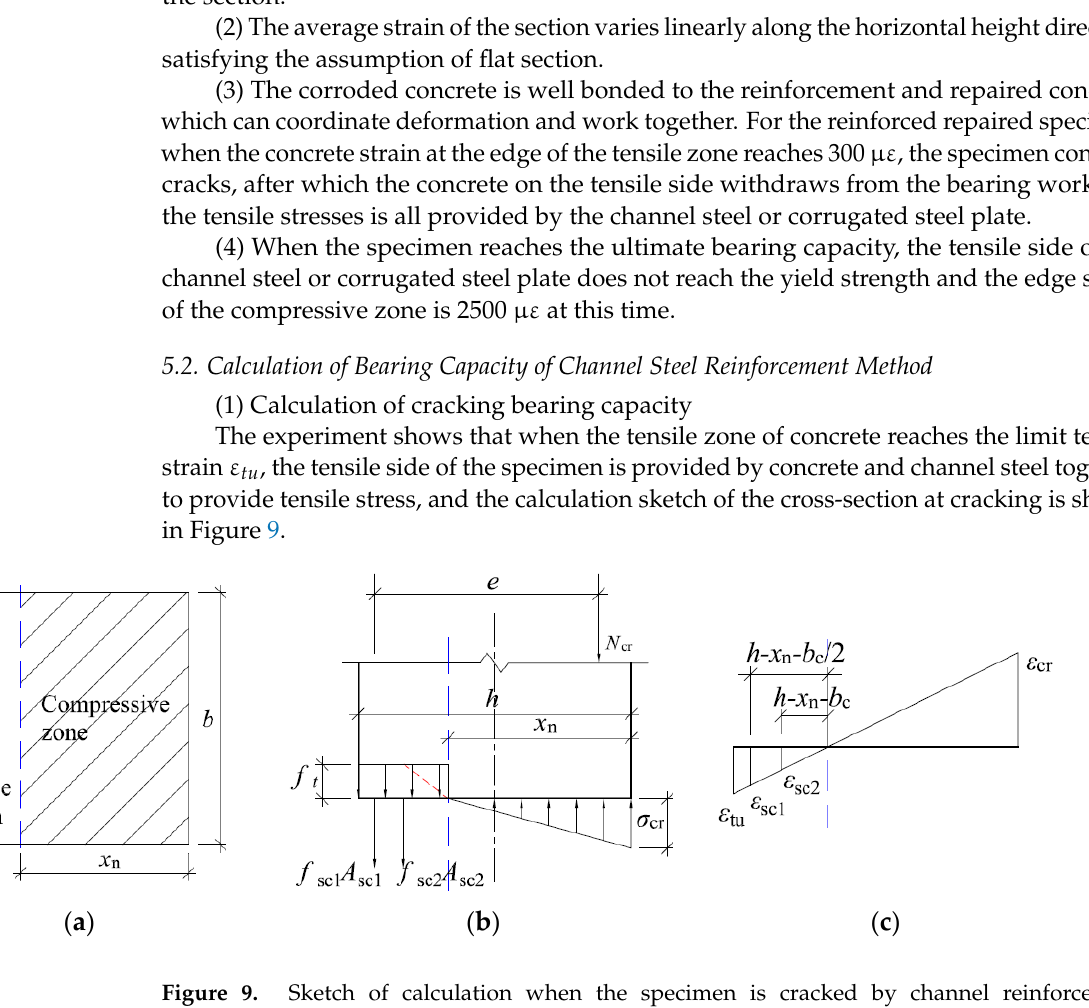
Figure 9. Sketch of calculation when the specimen is cracked by channel reinforcement method. ( a ) Cross-sectional view at cracking; ( b ) Cross-sectional stress distribution at cracking; ( c ) Cross- sectional strain distribution at cracking.